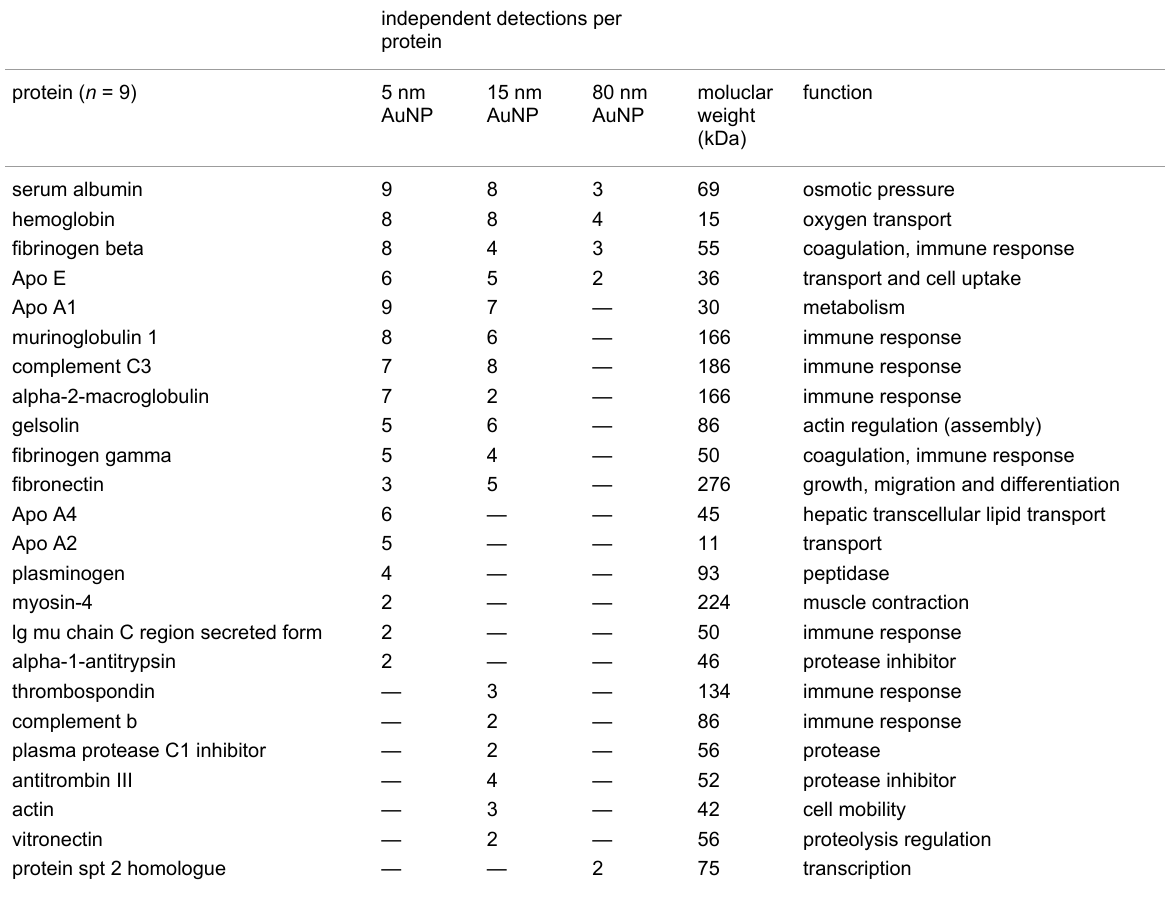
Table 2: Selection of murine serum proteins bound to the differently sized AuNP after 24 h of incubation. A total of nine SDS gels per AuNP were investigated by using proteome analysis (MALDI–TOF MS). Only proteins are listed that were detected at least twice. independent detections per protein protein ( n = 9) 5 nm AuNP